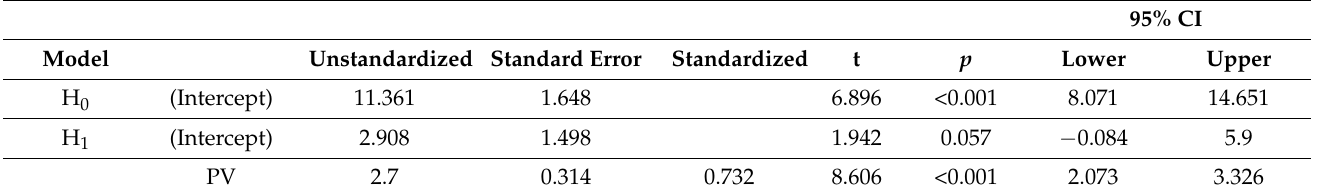
Table 7. Vertical dry plate method and wet candle method—coefficient of linear regression analysi.